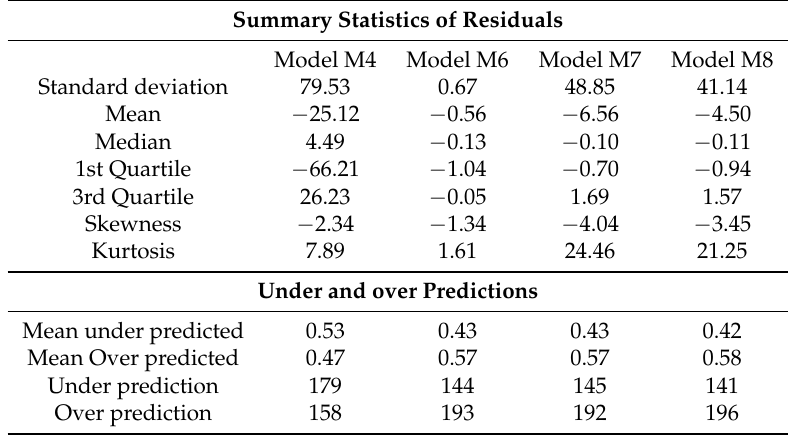
Table 5. Summary statistics of the residuals of the models.